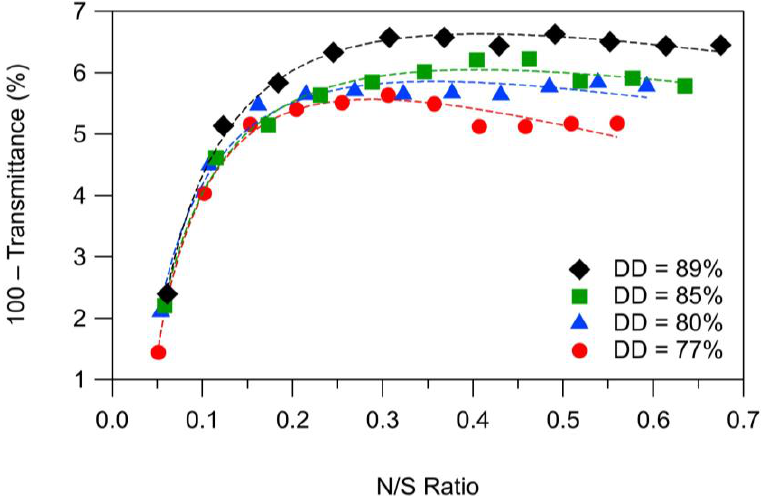
Figure 3. Titration curves for turbidimetric titrations of CNC-18 suspensions with solutions of chitosans with DDs ranging from 77 to 89%. (The dashed lines are merely visual guides. Each data point is a mean of three measurements. Error bars are omitted for clarity.) N/S ratio = number of chitosan amino groups divided by number of CNC sulfate groups, 100 − Transmittance of deionized water = 0%.